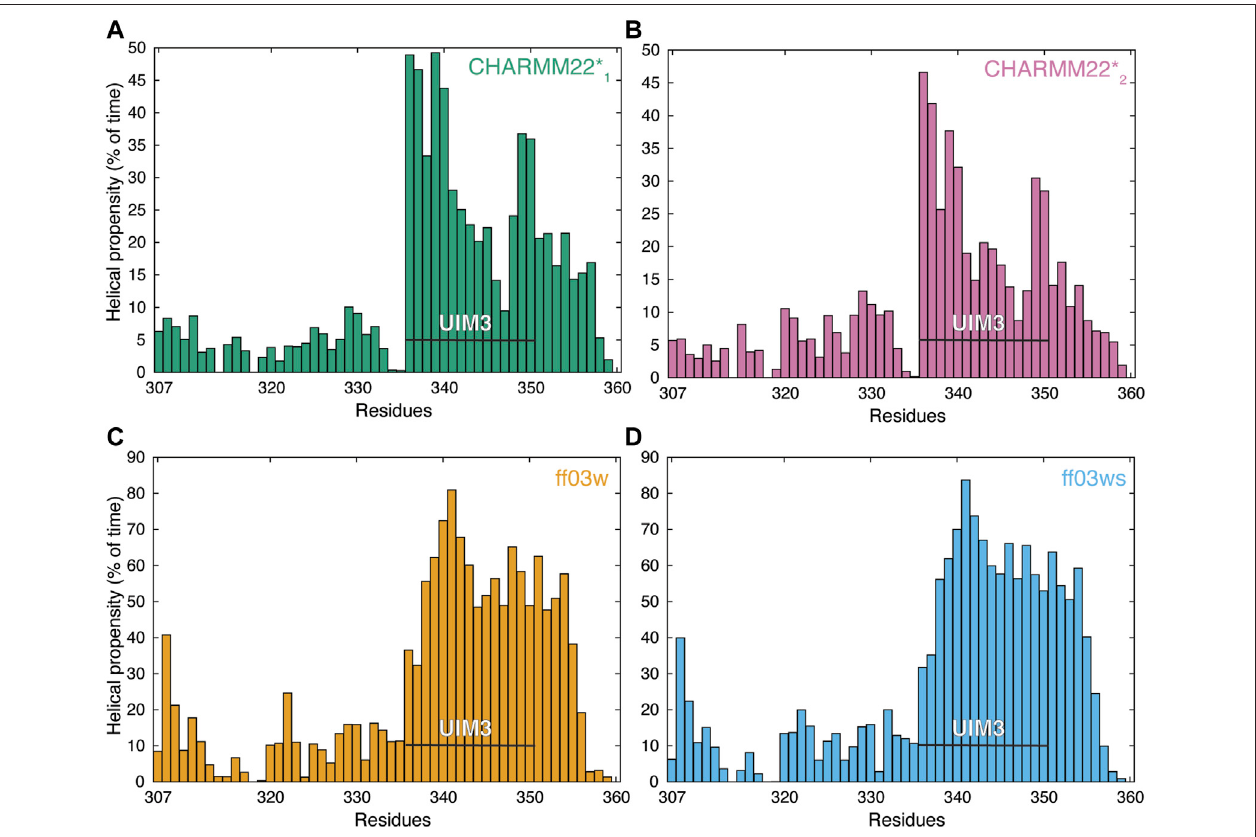
FIGURE 2 | AT-3 306-361 in the free state assumes both helical and non-helical conformations. The panels show the per-residue helical content of each replica at 304 Kfrom theREMD simulations oftheAT-3 306-361 foreach combinationofprotein force fi eldsand water models: (A) CHARMM22*-TIP3P (CHARMM22* 1 , green), (B) CHARMM22*-TIPS3P (CHARMM22* 2 , pink), (C) Amber ff03w-TIP4P/2005 (ff03w, orange), and (D) Amber ff03ws-TIP4P/2005 (ff03ws, blue). The residues of UIM3 (residues 336 – 350) are highlighted by the black bars. The REMD simulations with ff03w and ff03ws show high helical content for UIM3 while the CHARMM22* 2 simulation reports more disordered and heterogeneous conformations of